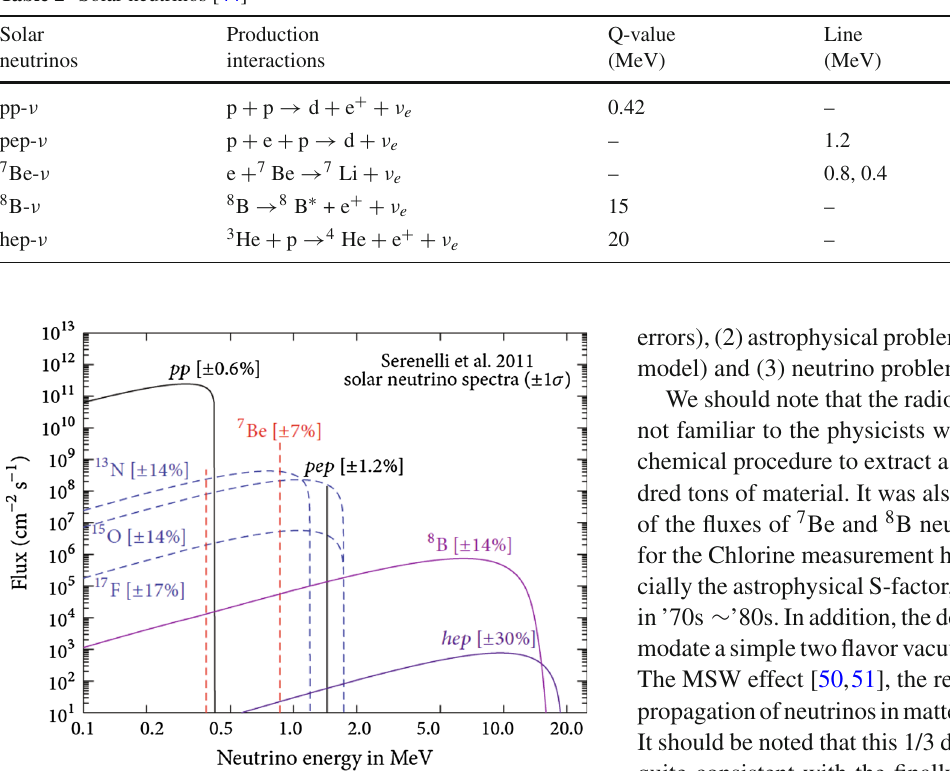
Fig. 7 Solar neutrino spectrum [47]. Super-K is able to measure only 8 B-solar neutrinos above 3.5 keV